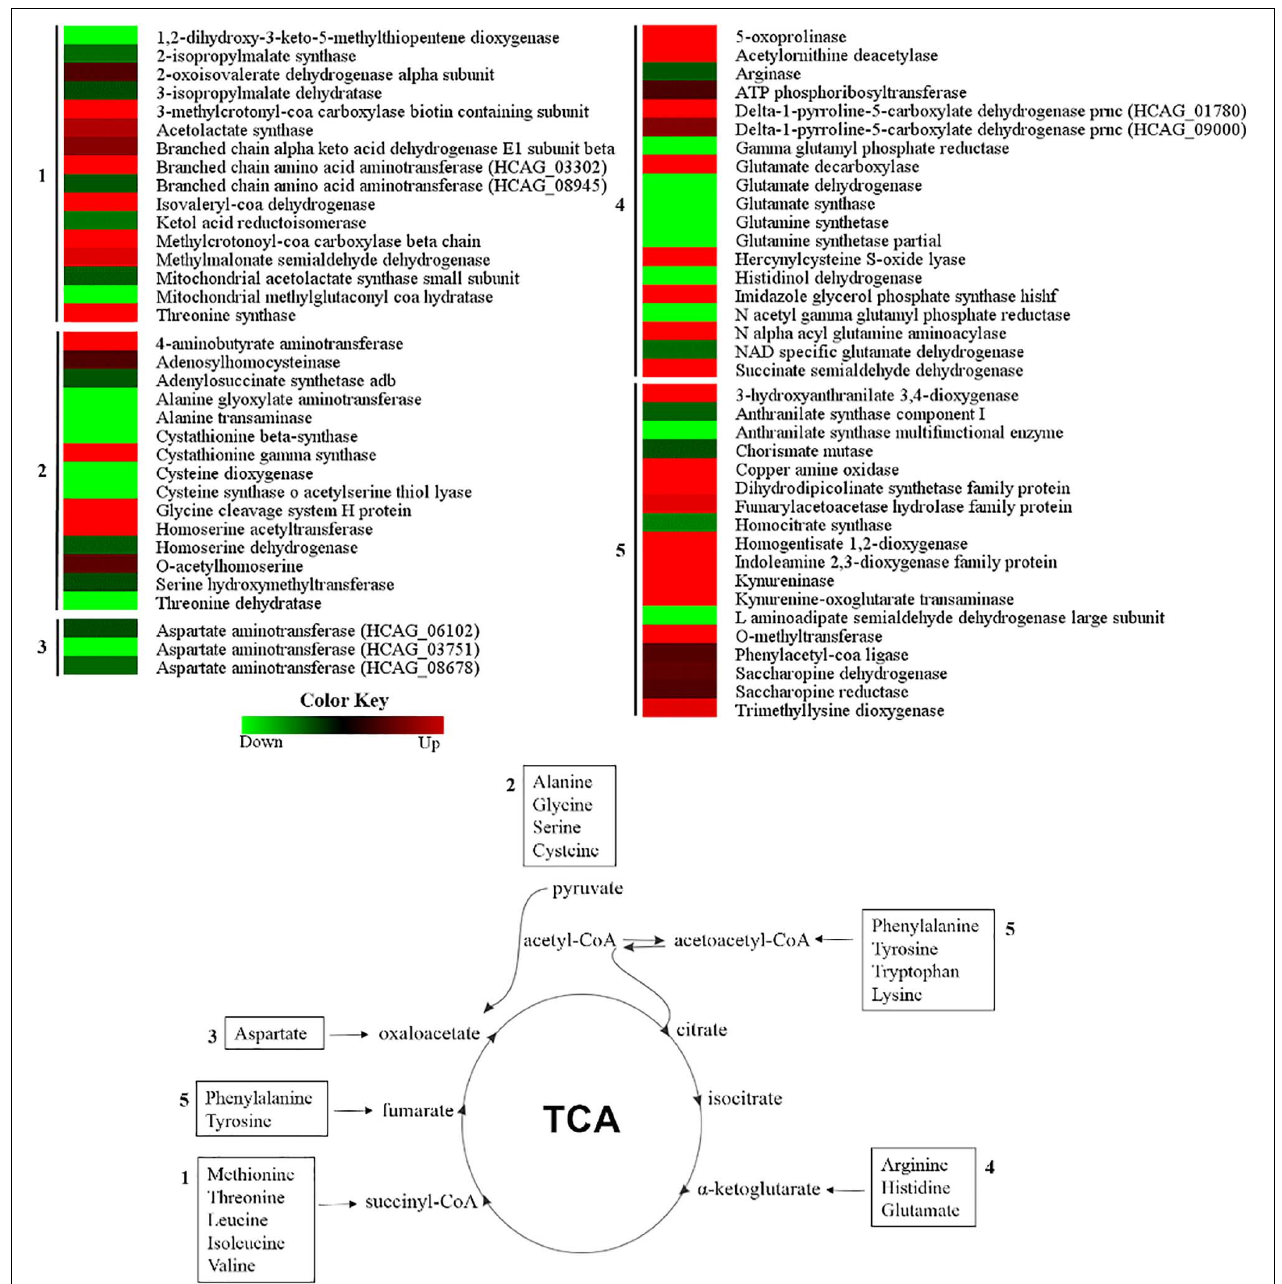
FIGURE 5 | Comparison of protein profiles related to amino acid metabolism in H. capsulatum mycelium and yeast forms. Dataset comparisons were carried out as cited in the Figure 2 legend. Changes in the abundance levels in the mycelium compared with the yeast are represented in the heat map. Experimental triplicate mean values are presented for the lowest (green) and the highest (red) abundance of H. capsulatum proteins in the mycelium form. Black indicates that no significant difference was